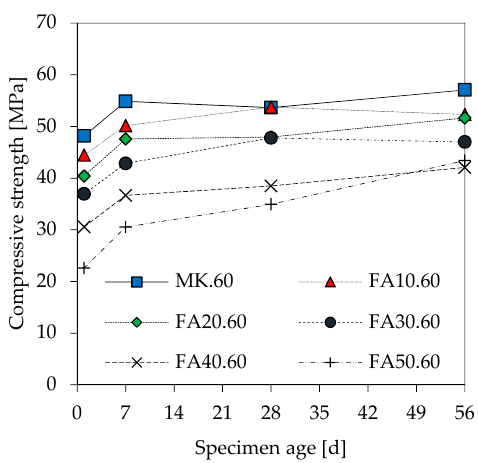
Figure 7. Evolution of compressive strength of geopolymer samples (l/s 0.60).